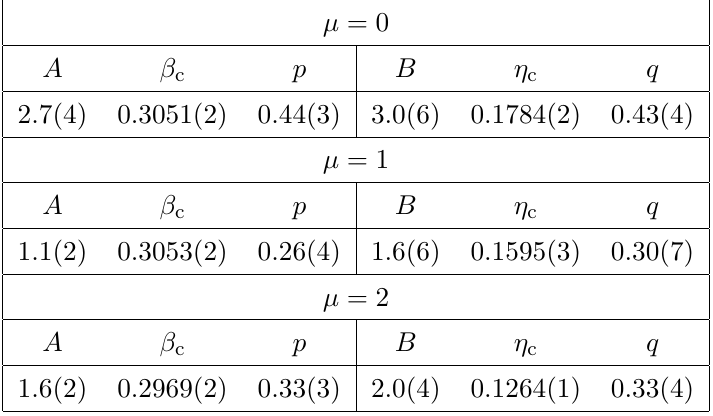
Table 4 . Fit results for ∆ h L i . All the results are obtained with D = 48 in the TRG method.